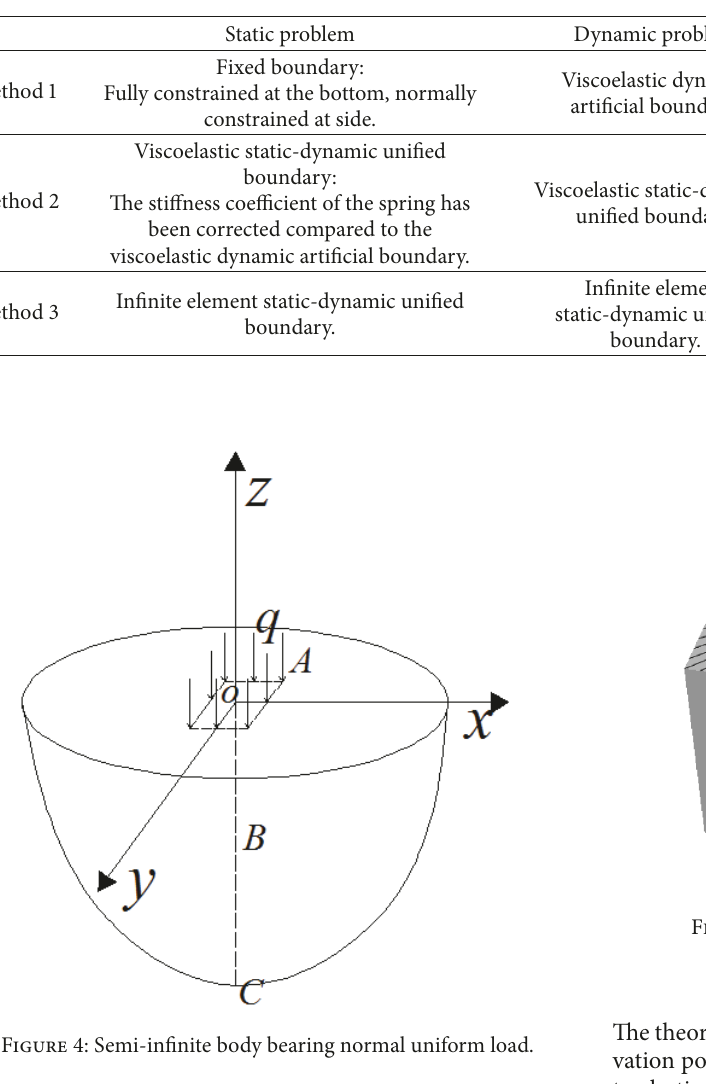
Table 1: Illustration of boundaries in each method for different problems.